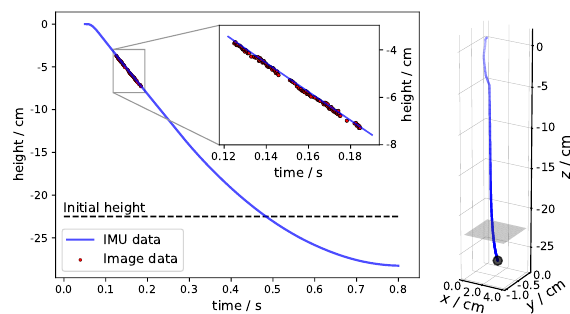
Figure 4. Left panel: Reconstructed trajectory of the projectile in the z direction as a function of time. Inset magnifies the free flying time before the projectile reaches the granular surface. Red dotted lines are positions obtained from side view images; Right panel: Sample trajectory of the projectile reconstructed from the sensor data. The plane shaded in light gray represents granular surface in the initial